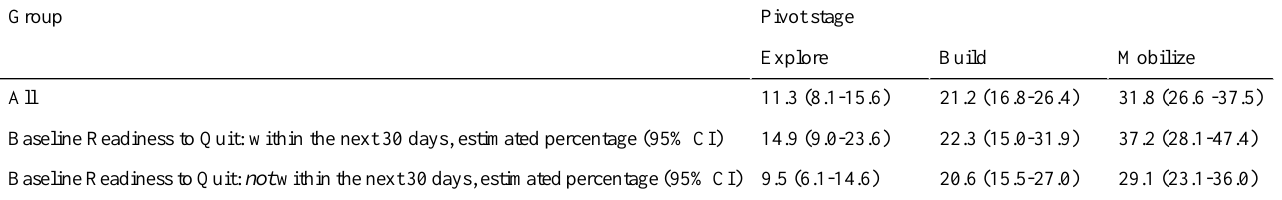
Table 7. Proportion of participants who reduced cigarettes per day (CPD) by ≥ 50% by pre-Quit stage, repeated measures linear mixed model analysis.